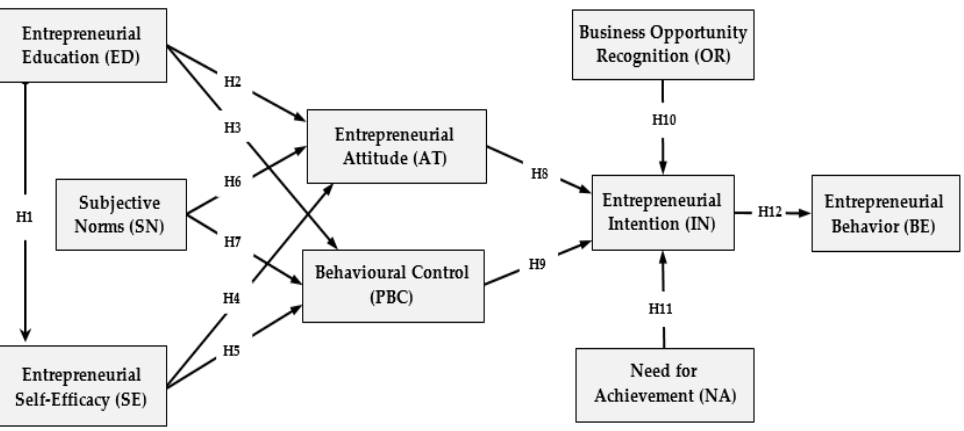
Figure 1. The proposed conceptual